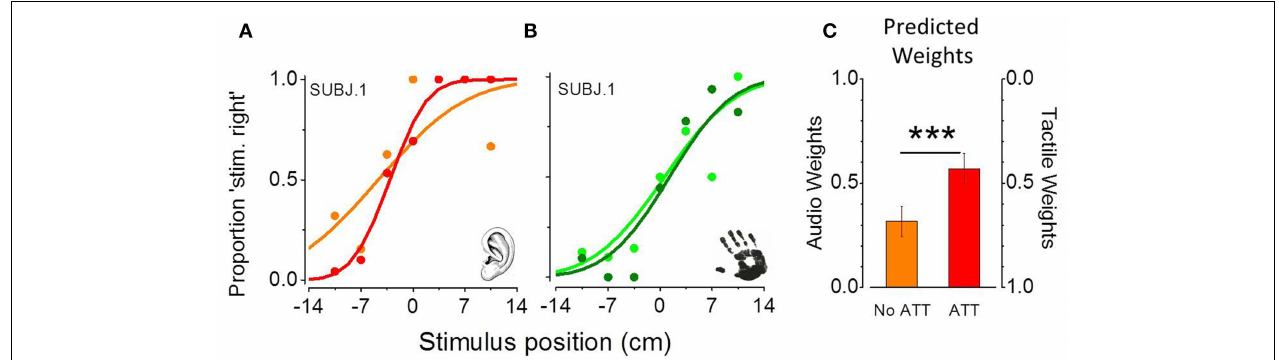
were fitted with cumulative Gaussians, to obtain PSE (50%) and threshold (standard deviation of the best-fitting function). Thresholds decrease in the attentional task only for the auditory condition. (C) Shows predicted average audio and tactile weights, calculated from individual thresholds in the two experimental conditions. Auditory weights are higher in the attentional condition. ( *** p - value < 0 . 001 ).